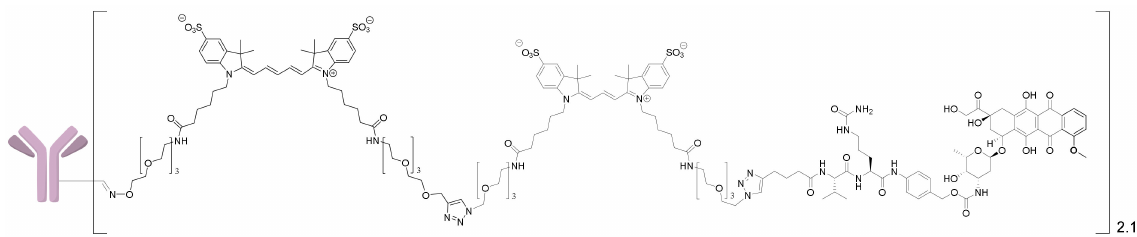
Figure 17. The structure of conjugate 14